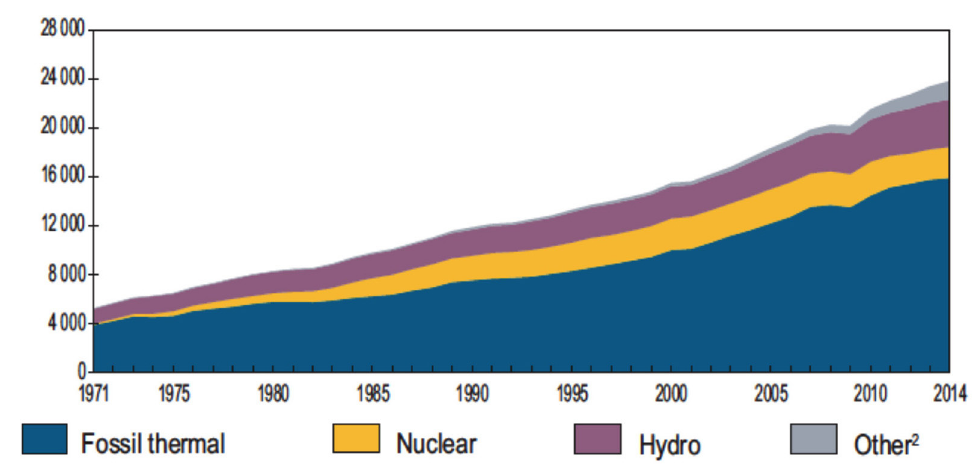
Fig. 5. – World electricity generation 1 from 1971 to 2014 by fuel (TWh). 1 Excludes electricity generation from pumped storage. 2 Includes geothermal, solar, wind, heat. (Courtesy of IEA.)